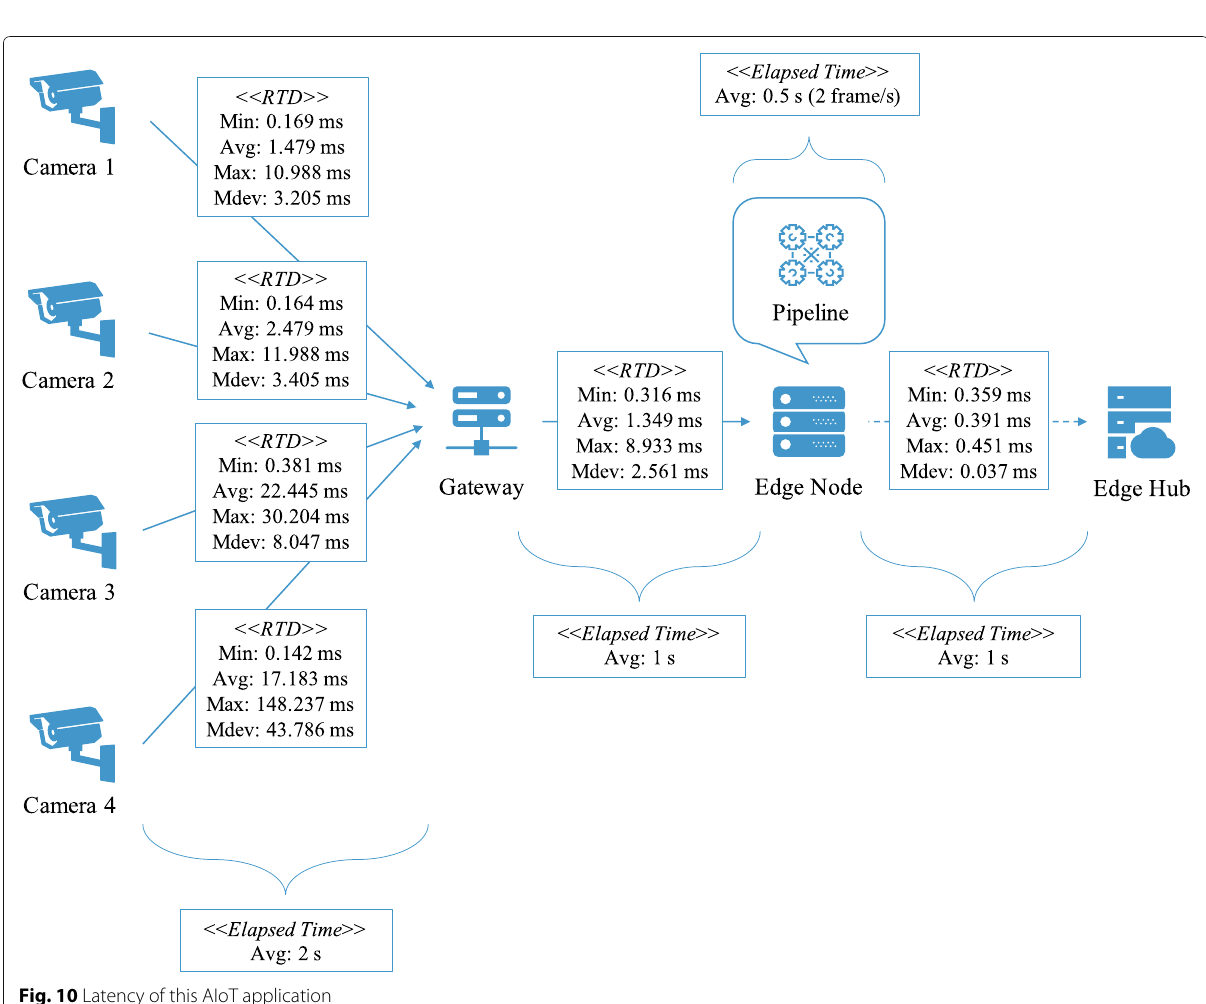
Fig. 10 Latency of this AIoT application